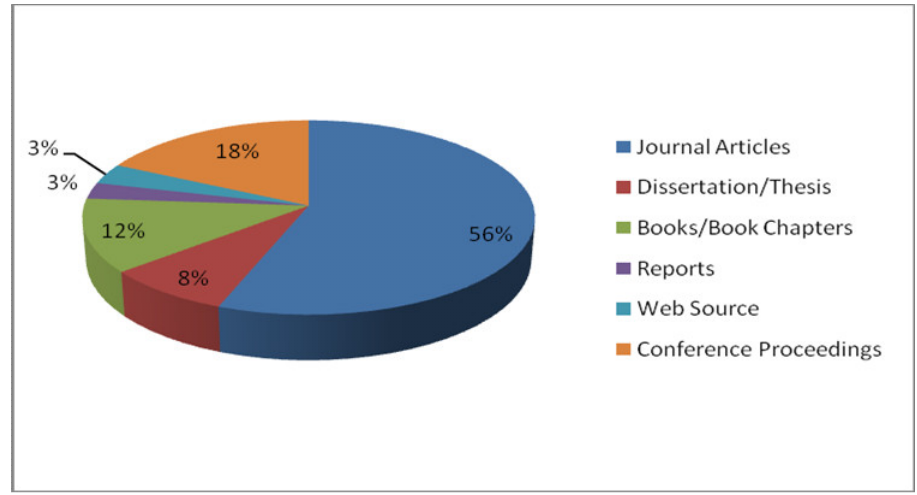
Figure 1. Distribution of scoping reviewed literature.